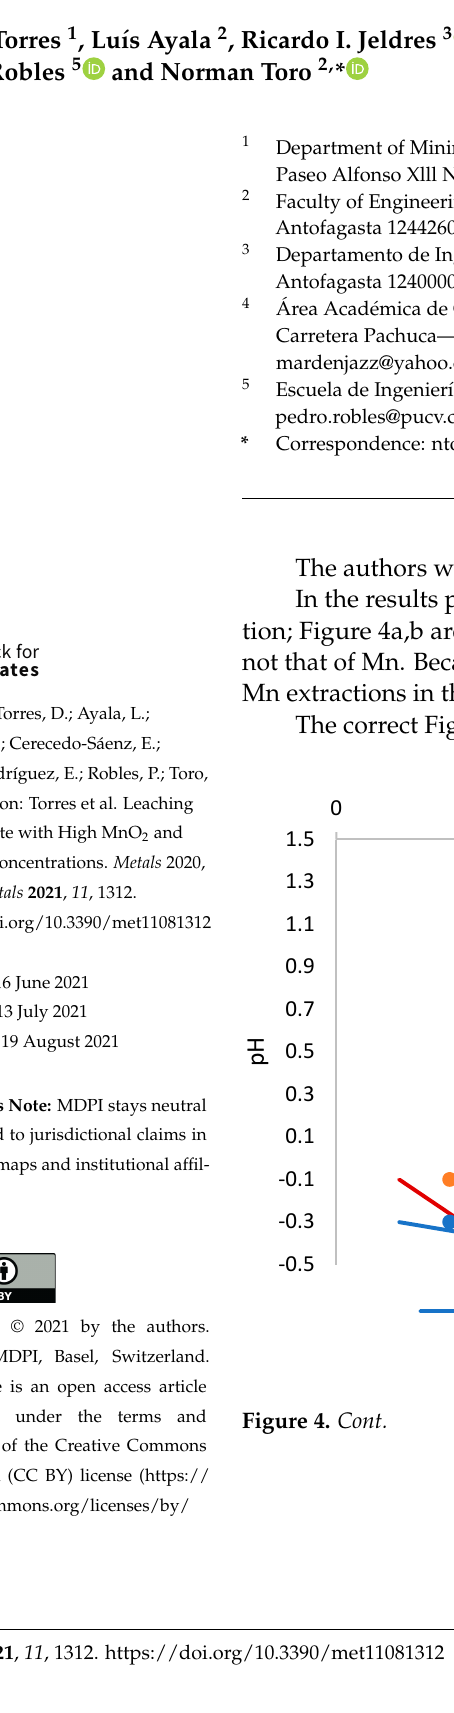
( b ) Figure 4. Dissolution of Fe and Mn over time from CuFeS2 at room temperature (25 °C) and high temperature (80 °C) ( a ): dissolution of Fe and its behavior at changes in pH; ( b ): dissolution of Mn and its behavior at changes in pH). We will update the article and the original version will remain available on the article webpage. Author Contributions: All of the authors contributed to analyzing the results and writing the paper All authors have read and agreed to the published version of the manuscript. Funding: This research received no external funding. Institutional Review Board Statement: Not applicable. Informed Consent Statement: Informed consent was obtained from all subjects involved in the study. Data Availability Statement: Not applicable.